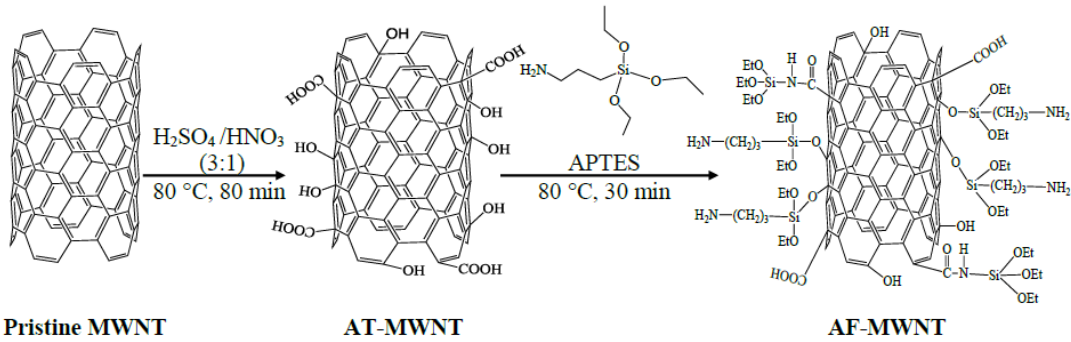
Figure 1. Scheme of the procedure for multi-walled carbon nanotubes (MWNT) modification.